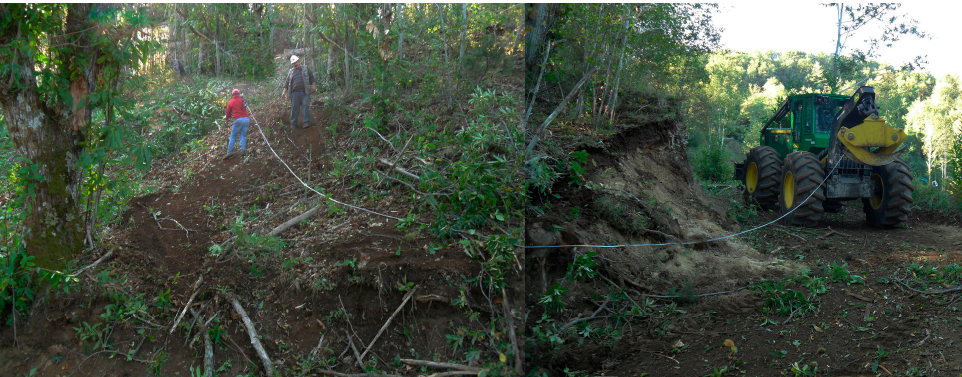
Figure 2. Extracting trees with a John Deere skidder at site A.